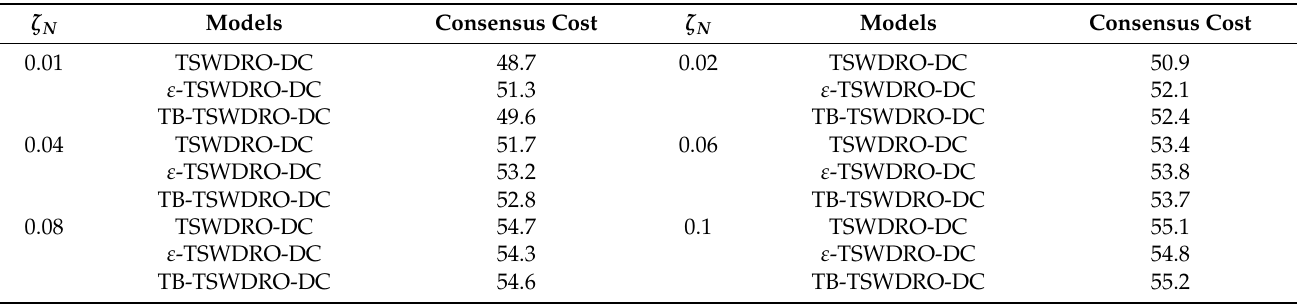
Table 2. Numerical simulation results.